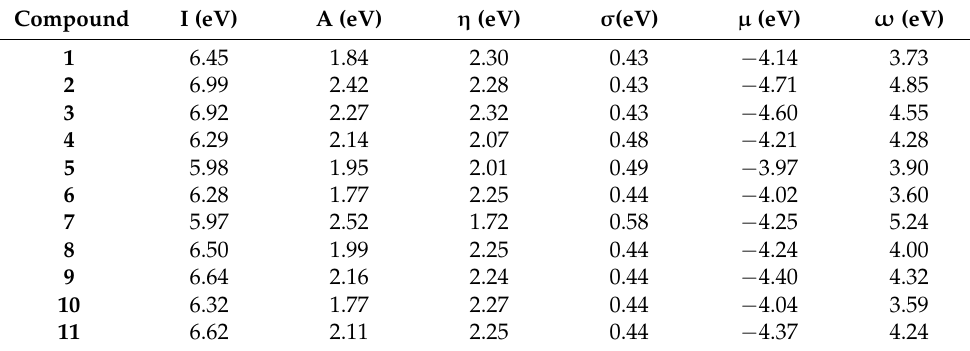
Table 7. The values of the important reactivity descriptors of compounds 1 – 11